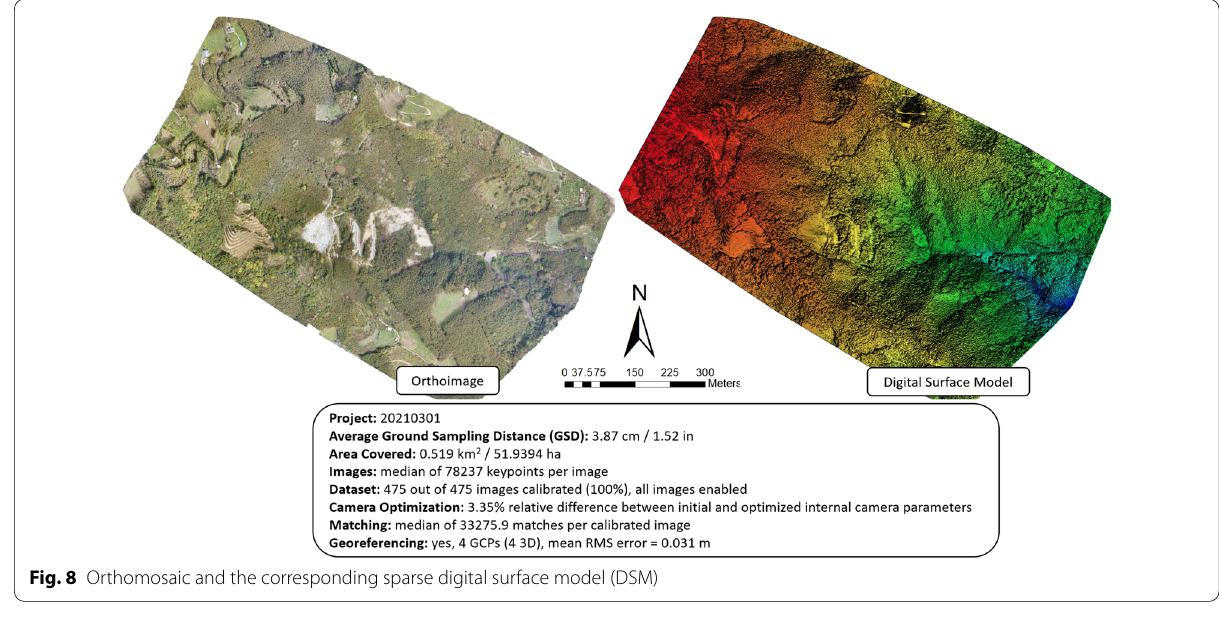
Fig. 8 Orthomosaic and the corresponding sparse digital surface model (DSM)